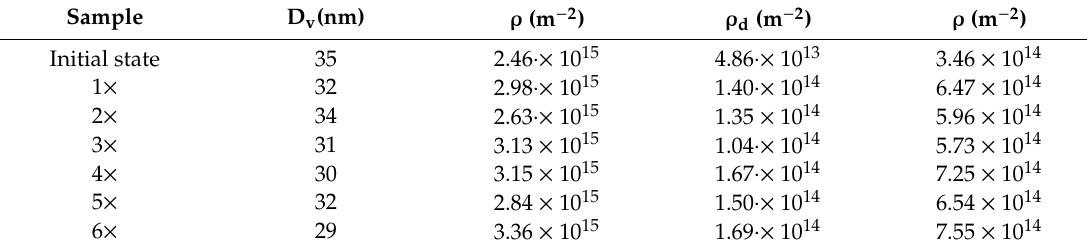
Figure 3. X-Ray di ff raction profiles of 5754 aluminum alloy in di ff erent conditions. Table 2. Structural parameters of the 5754 aluminum alloy determined by X-ray di ff raction peak analysis. D v = domain size; ρ d = dislocation density due to lattice microstrain; ρ s = dislocation density due to size e ff ect; ρ = total dislocation